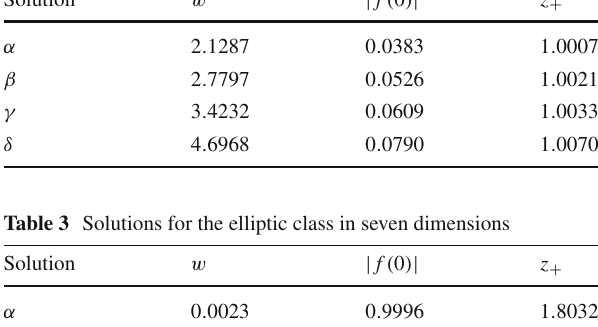
Fig. 3 Profile of α solution for elliptic case in seven dimensions ( K ω, K Im f ( 0 )) , since both e.o.m.’s and the G (ω, Im f ( 0 )) are invariant under this scaling. Hence, the ratio ω/ Im f ( 0 )